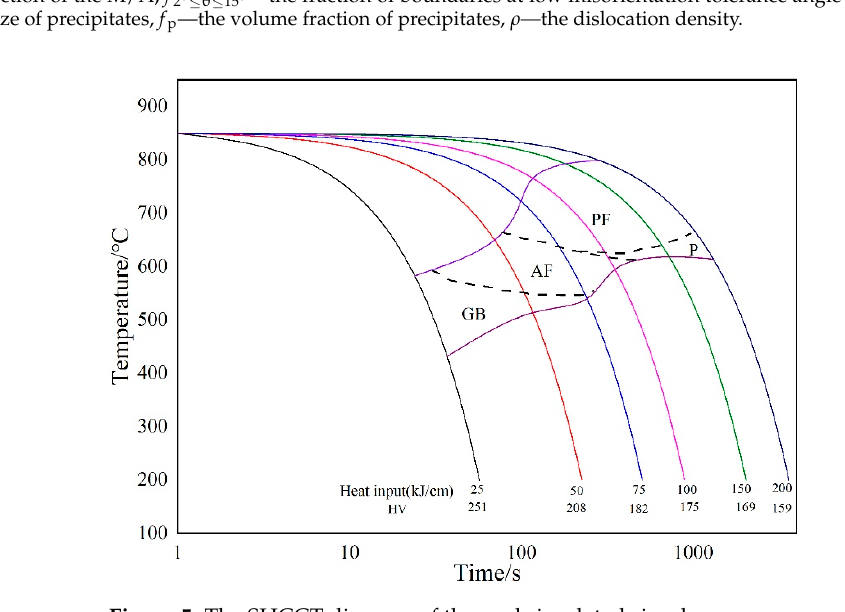
Figure 5. The SHCCT diagram of thermal simulated simples.